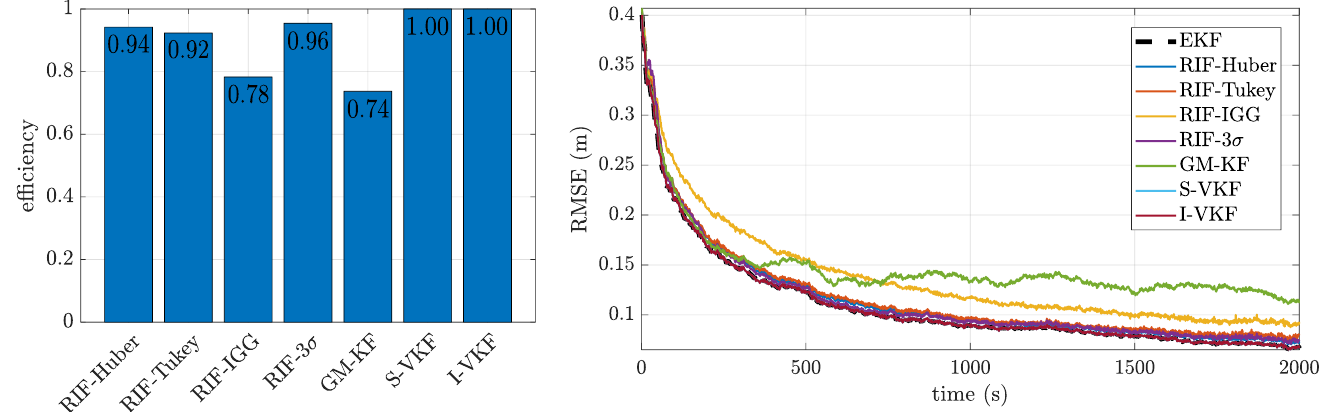
Figure 4. Efficiency and errors over time for the nominal Gaussian-distributed noise of case